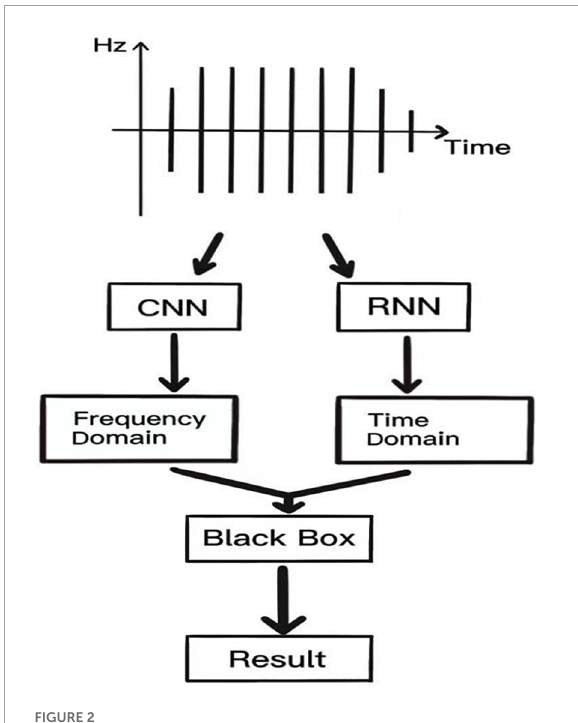
FIGURE2 Schematic diagram of a proposed neural network.